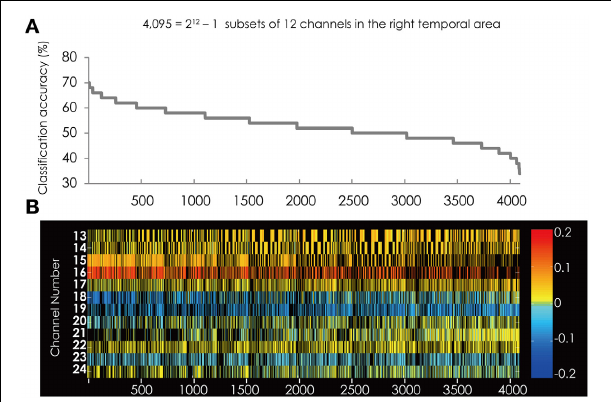
FIGURE 2 | (A) The classification accuracy corresponding with 4095 subsets consisted from the channels in the right hemisphere. Horizontal axis represents the rank-ordered subsets. Vertical axis indicates the classification accuracy. The highest accuracy is represented on the left side. (B) The channel numbers in the subsets represented in (A) . Horizontal and vertical axes represent the rank-ordered feature subsets and the channel numbers, respectively. Colored cells indicate that the channel was in the subset and black cells indicate that the channel was not in the subset. The color of each cell indicates a value of weight vector corresponding to the Z-score of each channel. Red/yellow spectrum indicates positive value and blue spectrum indicates negative